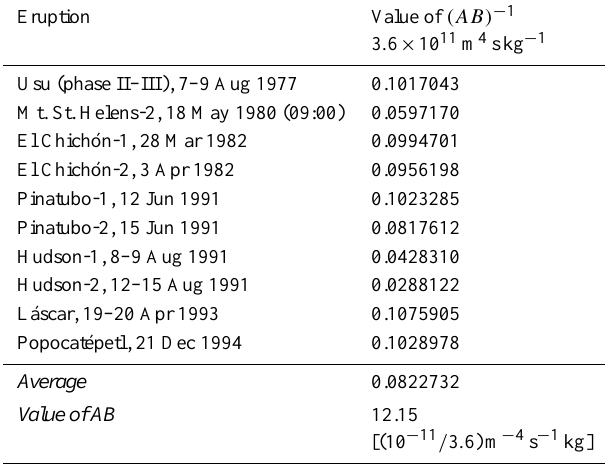
Table 4. Value of (AB) − 1 and AB for different eruptions. In all cases a density of 1100kgm − 3 has been used for the uncompacted ash